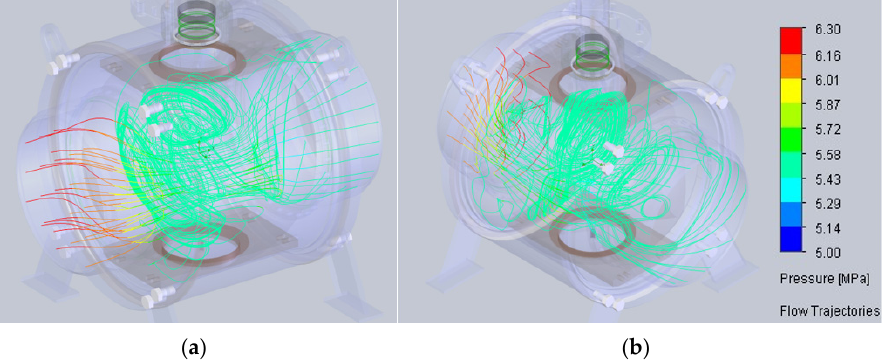
Figure 8. Pressure line trajectories for a 60° closure angle: ( a ) upstream view; ( b ) downstream view.